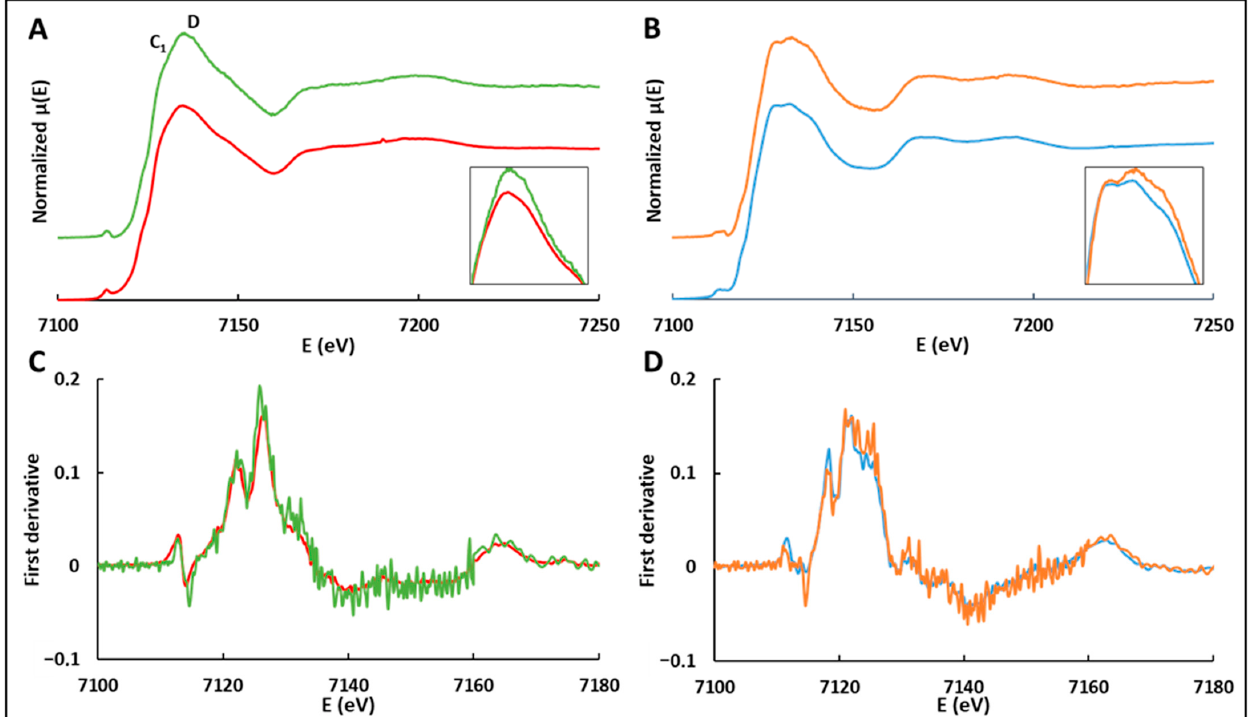
Figure 2. (Top) Normalized Fe K-edge XANES spectra of ( A ) adsorbed (green line) and free (red line) oxygenated hemoglobin (oxyHb); ( B ) adsorbed (orange line) and free (blue line) deoxygenated hemoglobin (deoxyHb). The insets show a magnification of the white line region. (Bottom) First derivatives of Fe K-edge XANES spectra of ( C ) adsorbed (green line) and free (red line) oxyHb; ( D ) adsorbed (orange line) and free (blue line) deoxyHb. The pre-edge and threshold positions of the Fe K-edge XANES spectra are given in Supporting Table S1. Data were recorded with 1.0 mM Hb in 0.1 mol.L − 1 phosphate pH 7.0 at 20 K for free oxyHb or free deoxyHb, and with 1.0 mM Hb and a NPs concentration of 120 g.L − 1 in 0.1 mol.L − 1 phosphate pH 7.0 at 20 K, 98% oxyHb, or deoxyHb were adsorbed.